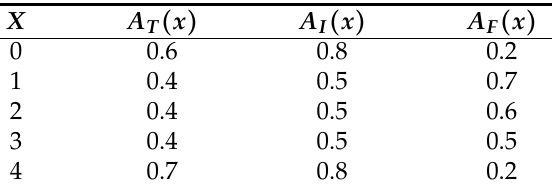
Table 2. Tabulation representation of A = ( A T , A I , A F )